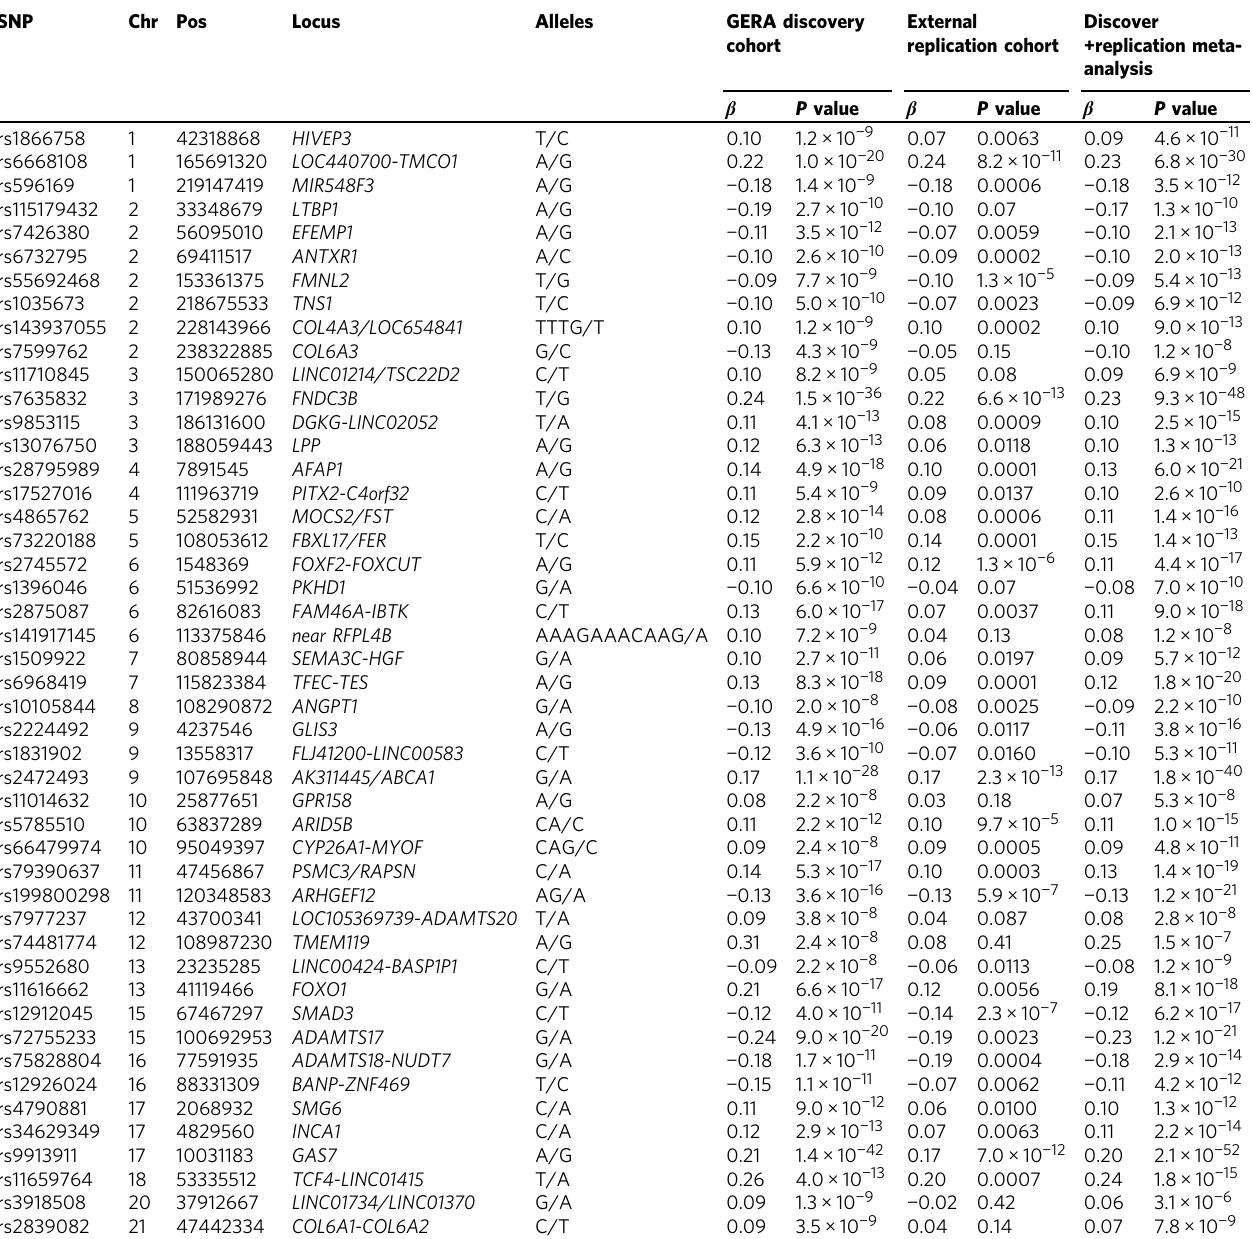
Table 2 Lead genome-wide signi fi cant SNP for each independent locus identi fi ed in the GERA discovery GWAS of IOP SNP Chr Pos Locus Alleles GERA discovery